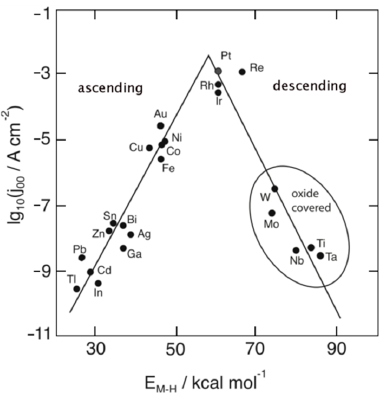
Figure 1. Trasatti’s volcano plot for hydrogen evolution in acid solutions: dependence of the common logarithm of the exchange current density ( j 00 ) from the energy of hydride formation (E M–H ). Reprinted from Reference [13], © 2020 Quaino et al.; licensee, Beilstein Institut.